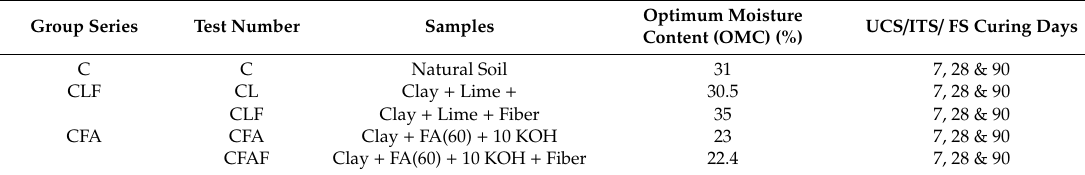
Table 5. Mixture proportion of the various